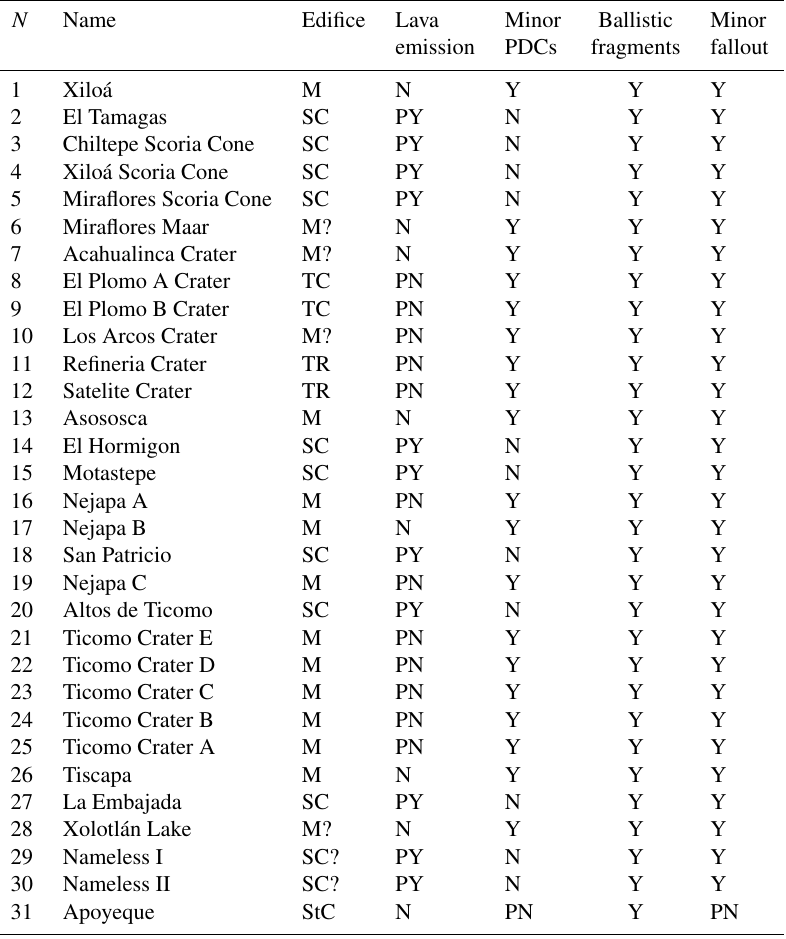
Table 2. Vents considered in the NCVC (Pardo et al., 2008; Freundt et al., 2010; Avellán et al., 2012).